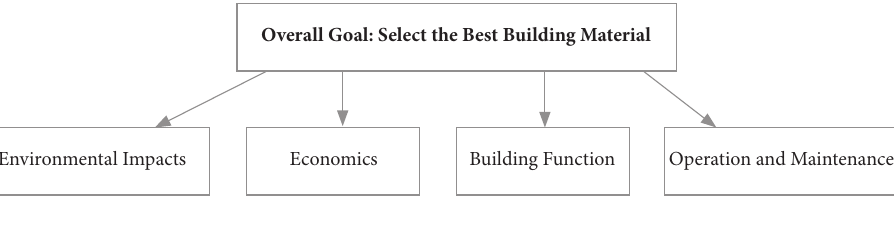
Overall Goal: Select the Best Building Material